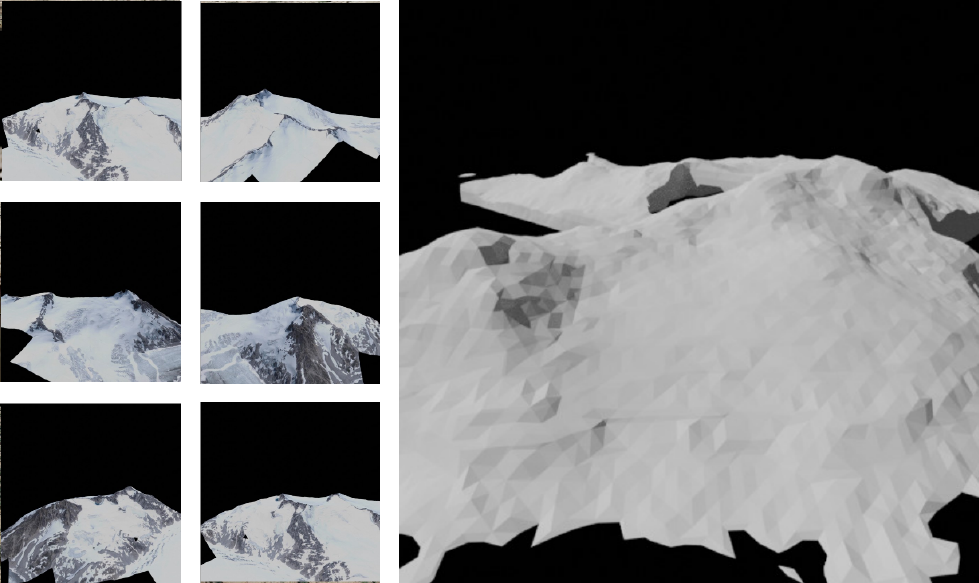
Figure 11. The real data of snowy mountain terrain. The small images on the left are the six views randomly shot by the camera, and the large image on the right is the reconstruction